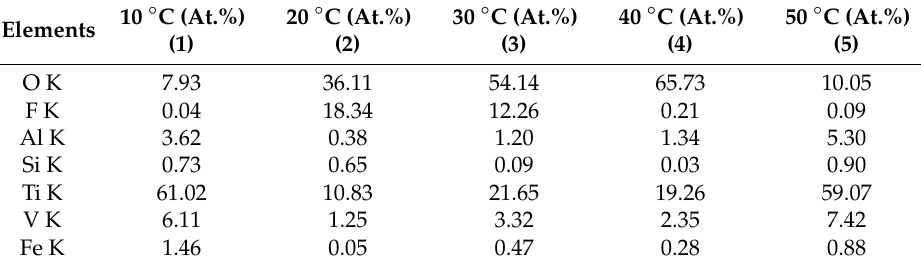
Table 5. The analysis results of corresponding EDS points in Figure